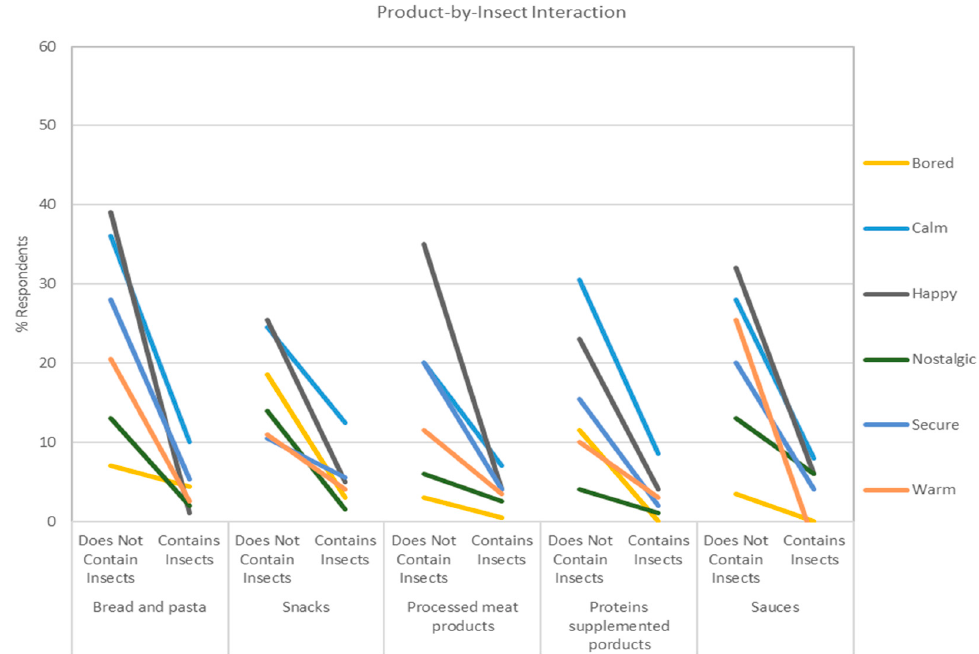
Figure 6. Effect of the interaction of the Insect Presence Information and the Product Category on the feelings bored, calm, happy, nostalgic, secure, and warm. The y-axis indicates the percentage of respondents checking the emotions, values which have been plotted using the regression model build from the ANOVA results, and the x-axis is the Insect Pres-ence Information by each Product Category.